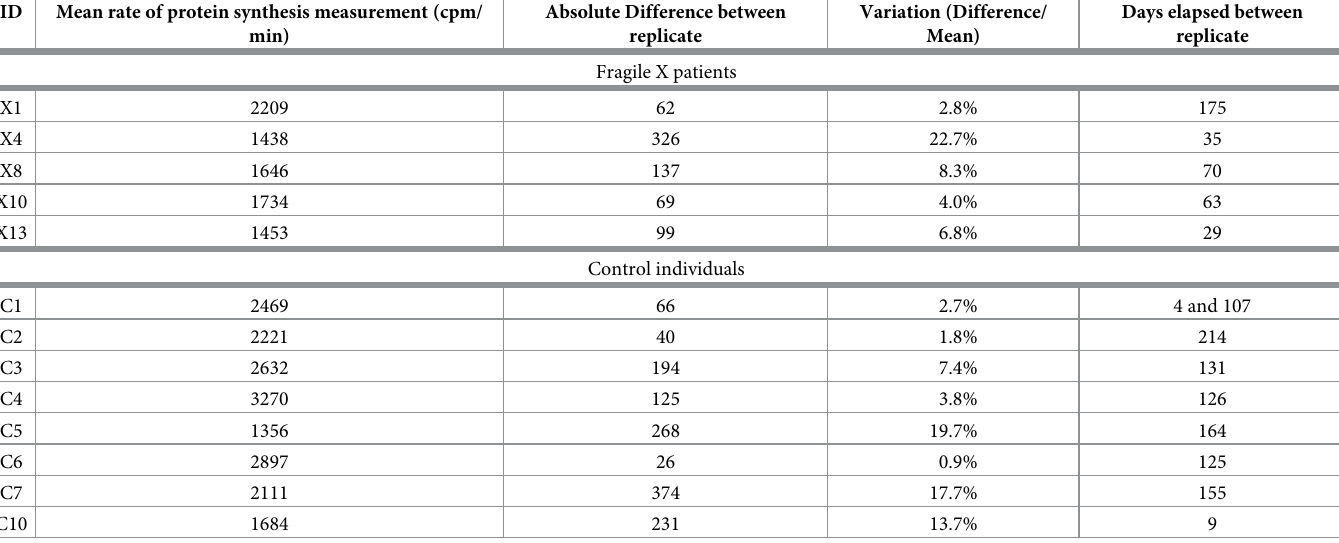
Table 1. Intraindividual variability of the rate of protein synthesis